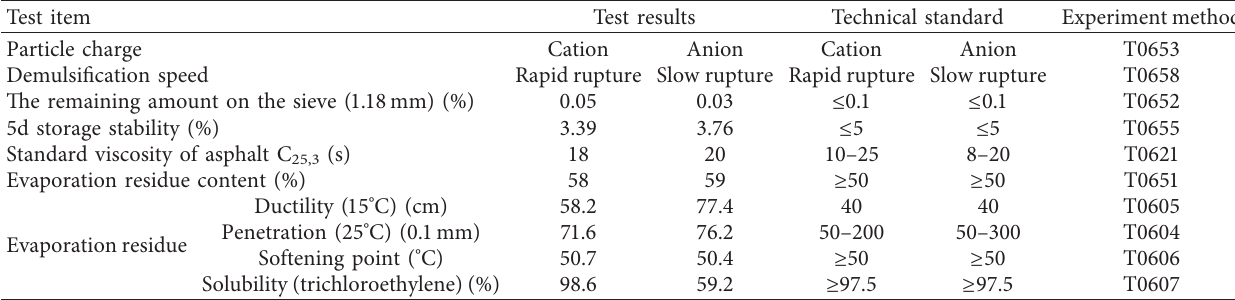
Table 4: Technical indices of emulsified asphalt.